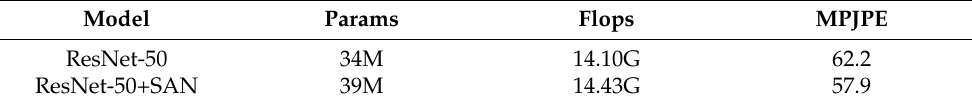
Table 2. Ablative study on computation complexity of models with and without